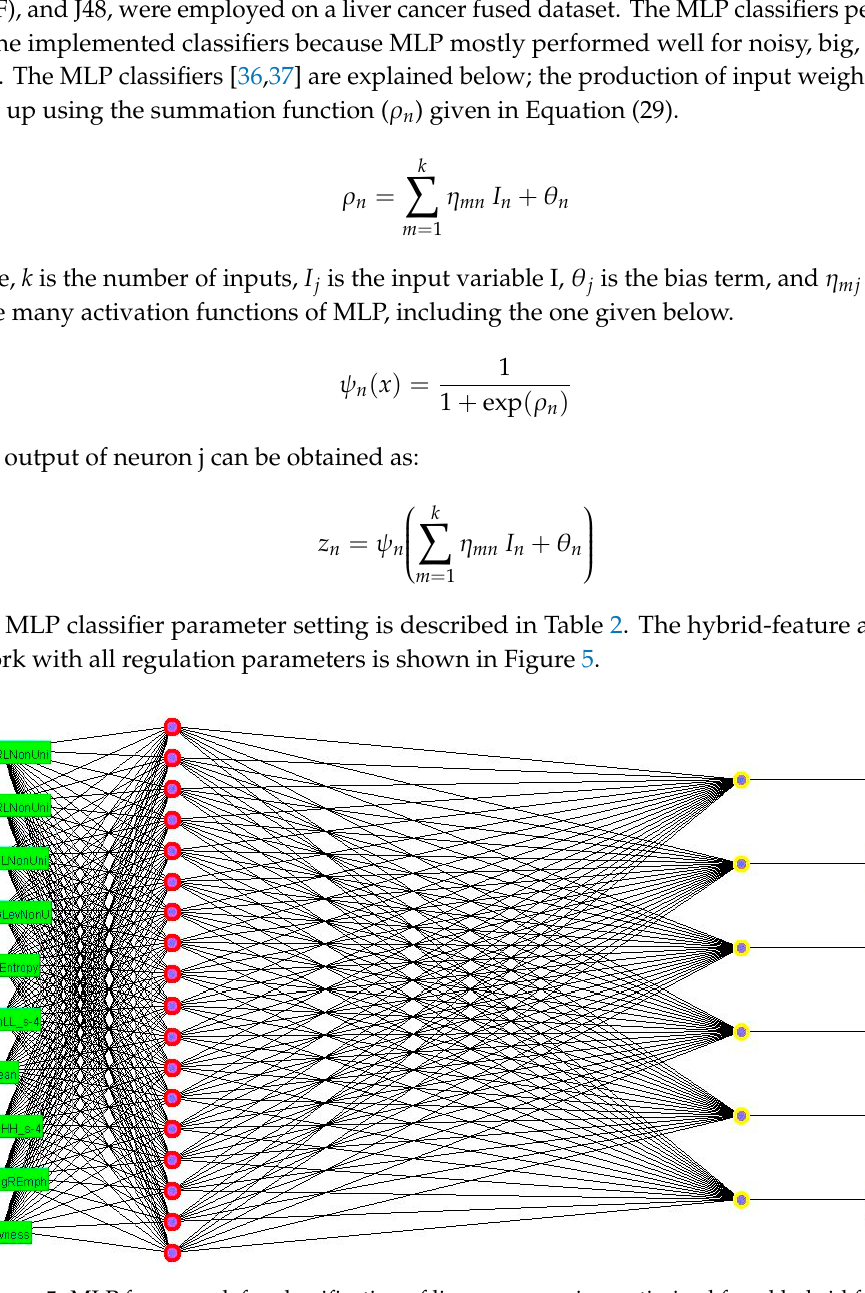
Figure 5. MLP framework for classification of liver cancer using optimized fused hybrid features. In the first layer, the input layer is defined in “green” with 10 features, while the second layer “red” shows the invisible layer with 18 neurons. The third layer, which has six “yellow” nodes showing the weights of the hidden layers, is the output layer. The regulation parameters along with their values are also shown above.